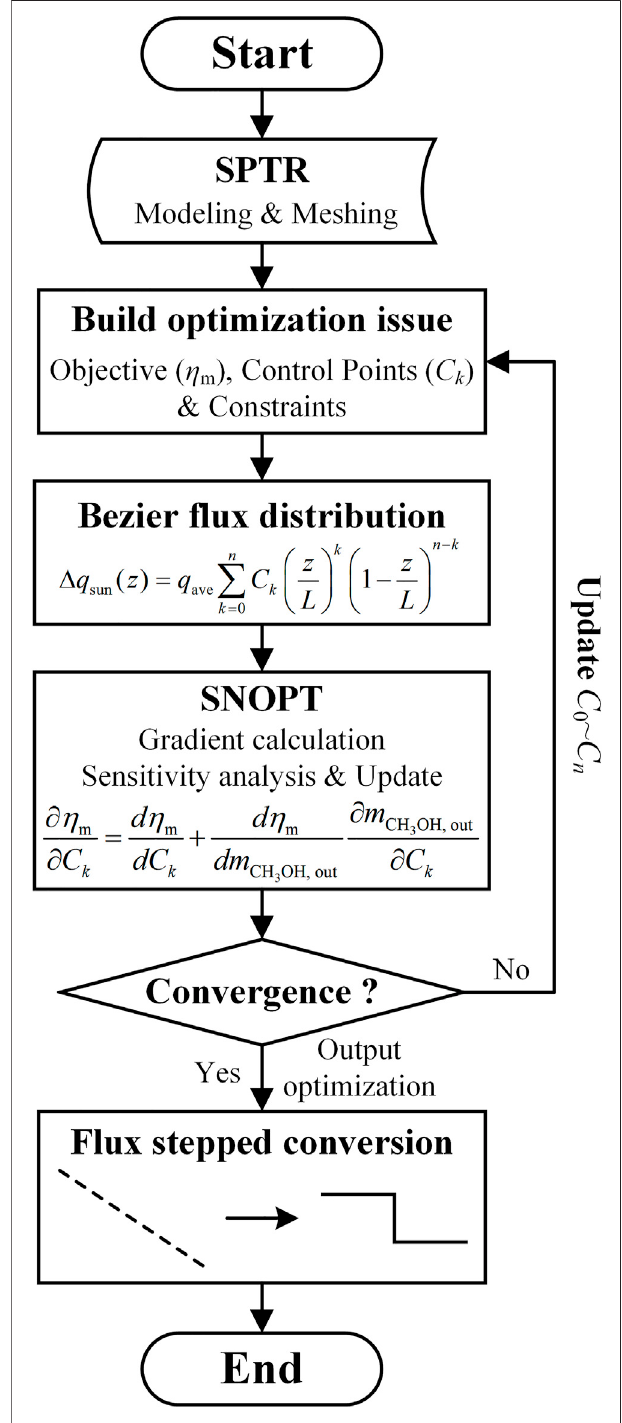
FIGURE 2 | Overall simulation and optimization fl ow